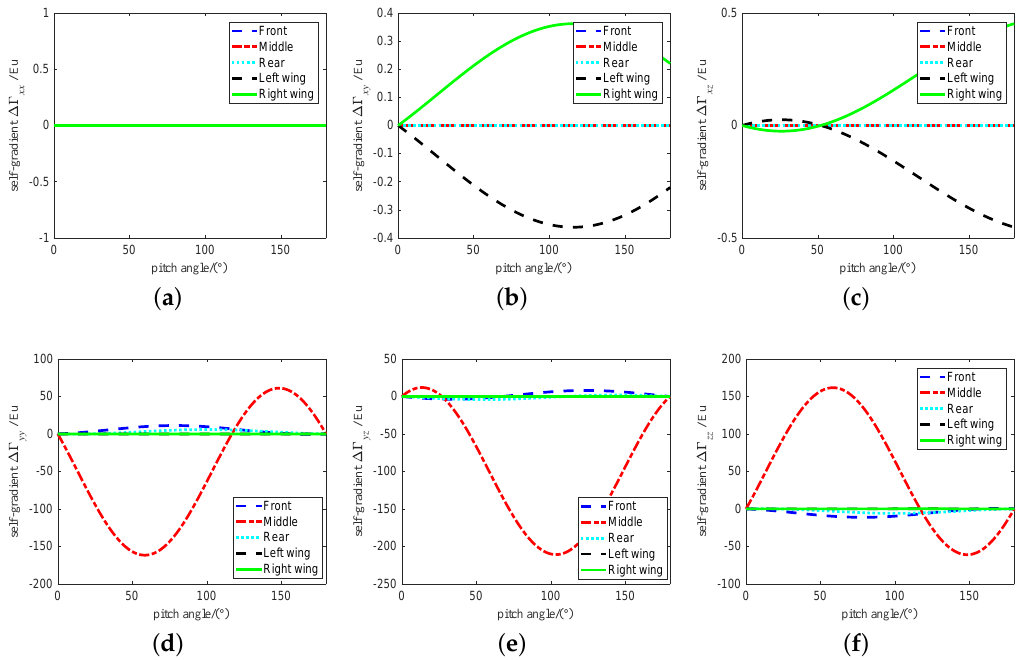
Figure 5. Self-gradient caused by the distribution mass of the carrier in pitch attitude. ( a ) Self-gradient element Γ xx . ( b ) Self-gradient element Γ xy . ( c ) Self-gradient element Γ xz . ( d ) Self-gradient element Γ yy . ( e ) Self-gradient element Γ yz . ( f ) Self-gradient element Γ zz .